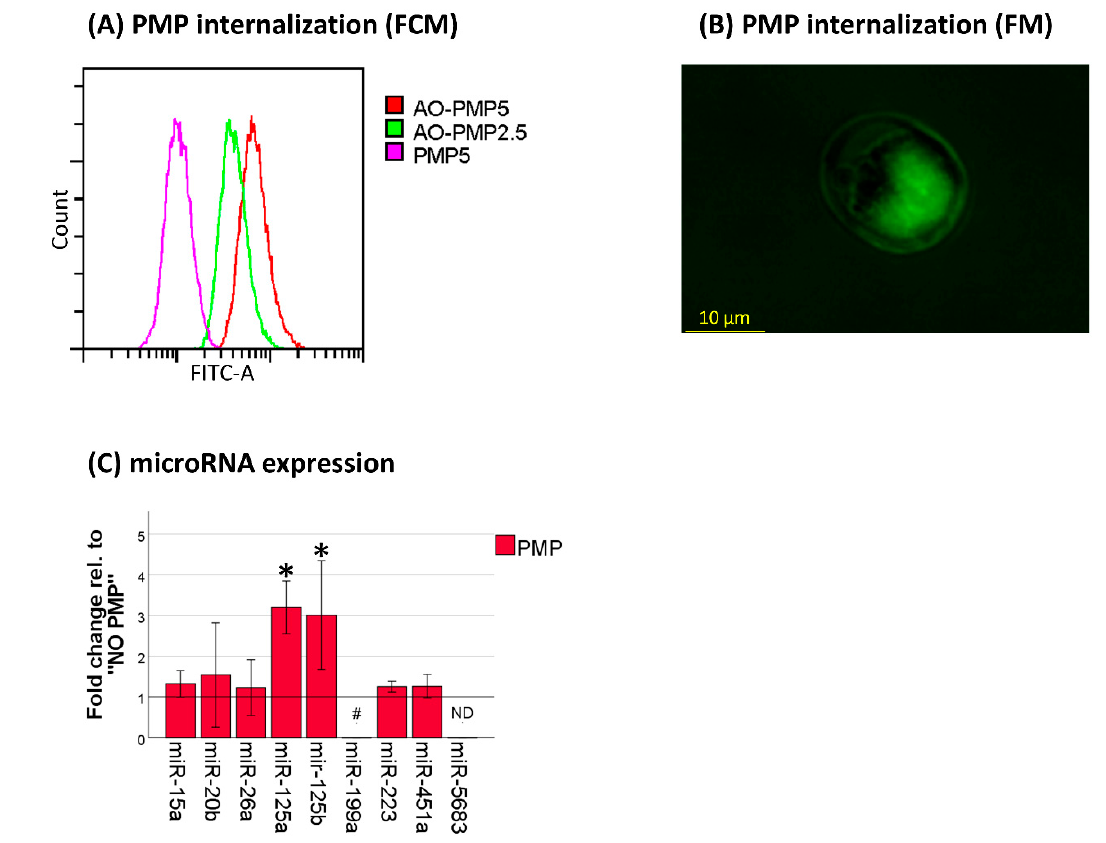
Figure 1. Internalization of platelet microparticles (PMPs) in THP-1 cells after 18 h of co-incubation. ( A ) Transfer of acridine orange from stained PMPs analyzed by flow cytometry (FCM). Histogram plot from a representative experiment ( n = 2). Number following different PMP groups denotes the final concentration in million PMPs per mL medium. AO, acridine orange. ( B ) Transfer of acridine orange from stained PMPs analyzed by fluorescence microscopy (FM) at 400 × magnification. ( C ) Changes in levels of microRNAs ( n = 3). microRNA data were calculated as fold change from THP-1 without PMP co-incubation, normalized for BCR . p values were calculated using the one-sample t test. * p < 0.05. #, fold change was not calcu- lated as levels were undetectable in 2/3 replicates for THP-1 without PMP co-incubation. ND, not detected.